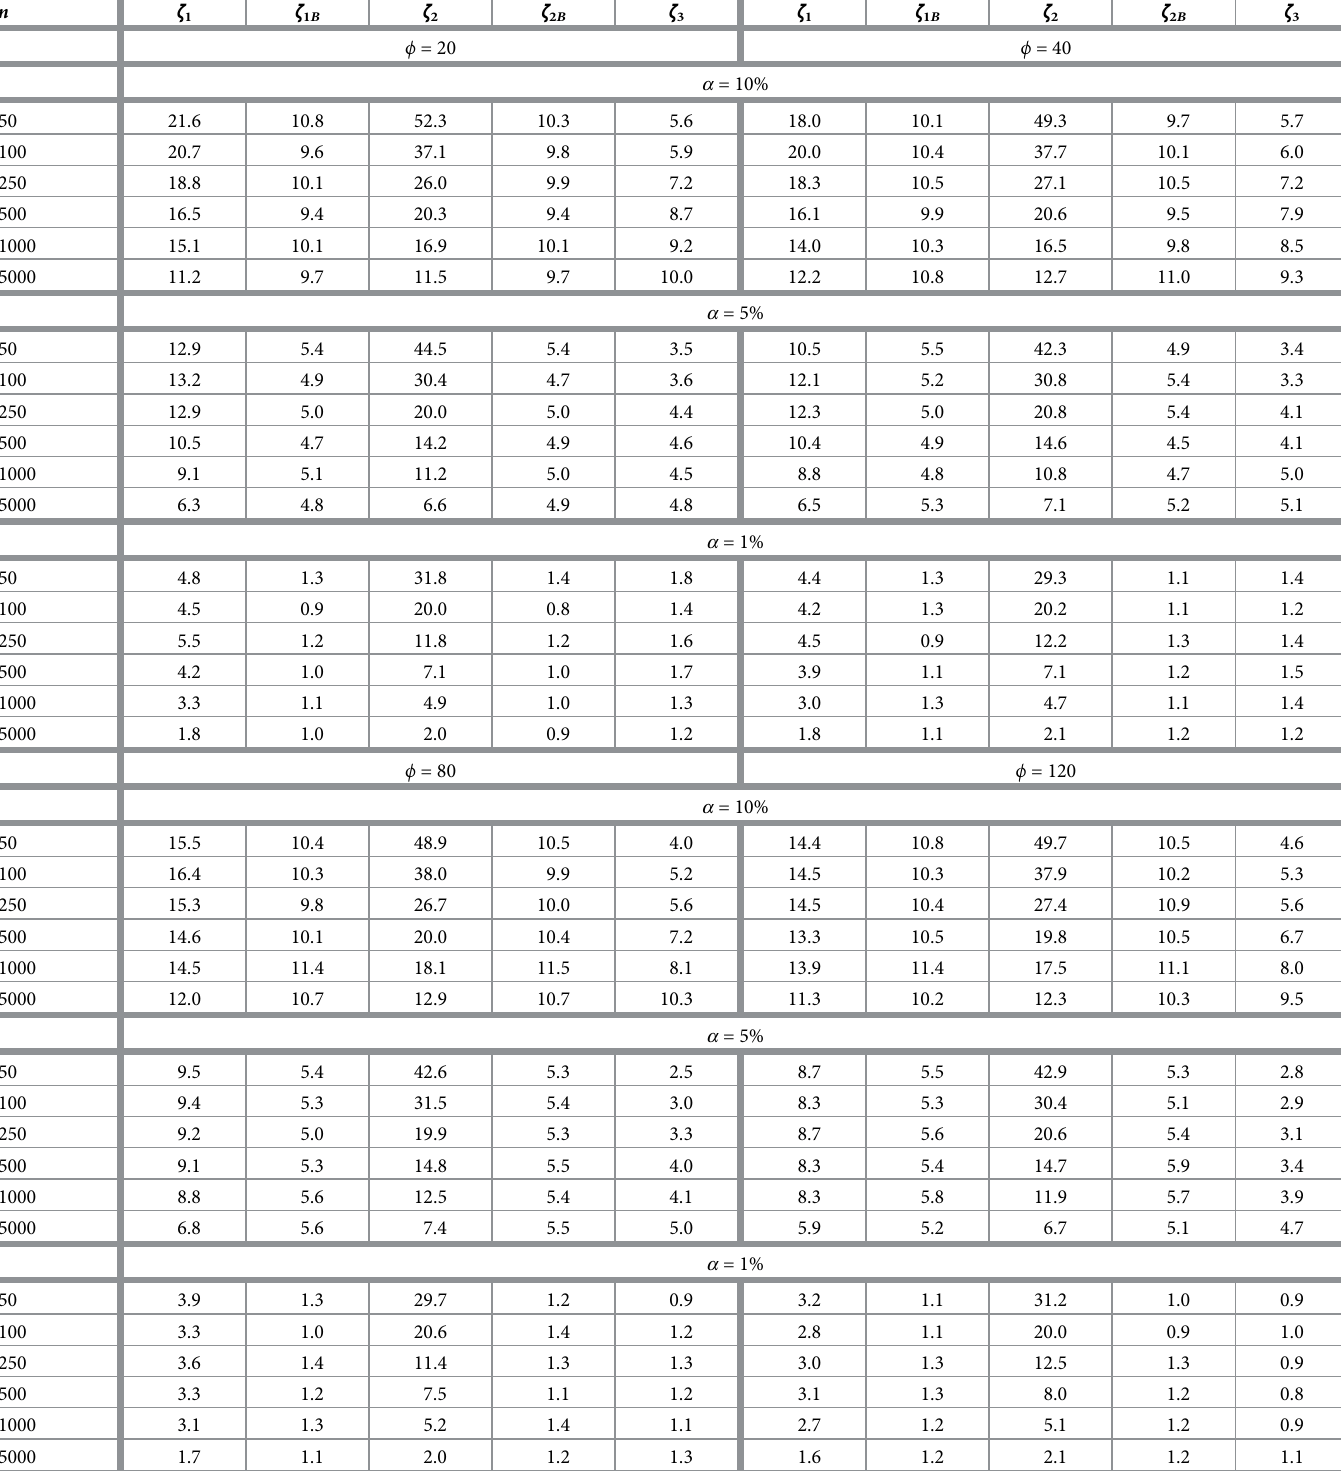
Table 3. Null rejection rates (%), μ =